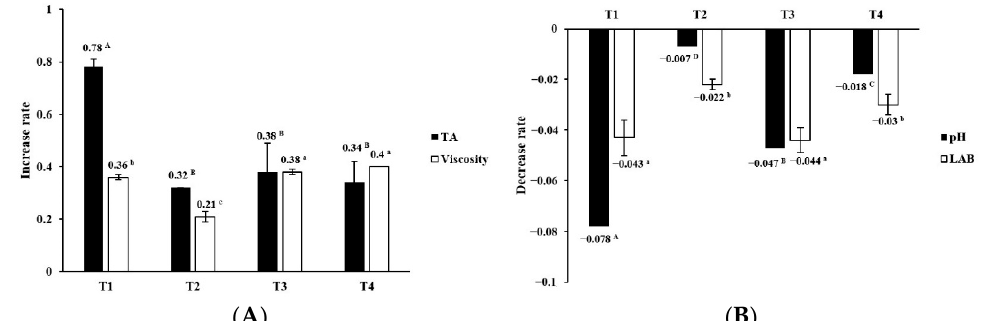
Figure 2. Change of physicochemical characteristics of Greek yogurt with different treatments dur ‐ ing storage for 21 days at 4 °C. S. thermophilus and L. bulgaricus (T1): x , S. thermophilus , L. bulgaricus and L. gasseri BNR17 (T2): ○ , S. thermophilus, L. bulgaricus and L. plantarum HY7714 (T3): ▲ , S. thermophilus, L. bulgaricus, L. gasseri BNR17, and L. plantarum HY7714 (T4): □ .